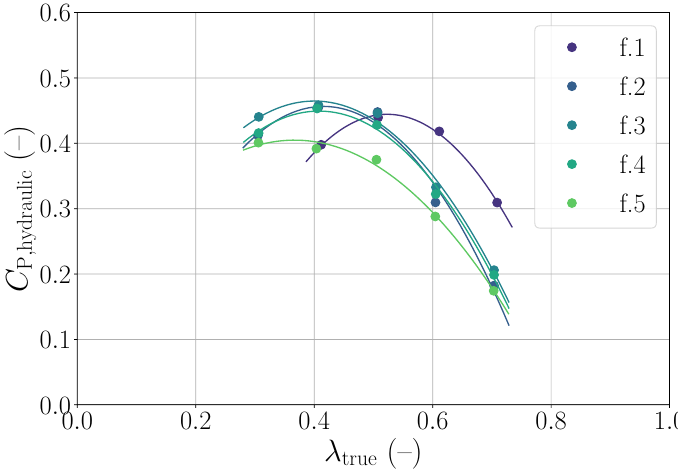
Figure 9. The hydraulic power coefficient of the five Pareto-optimal candidates, plotted as a function of the tip-speed ratio λ . The line colours correspond to the design configurations described in the legend. The corresponding trend curves are plotted using 2nd-order polynomial best-fit models.